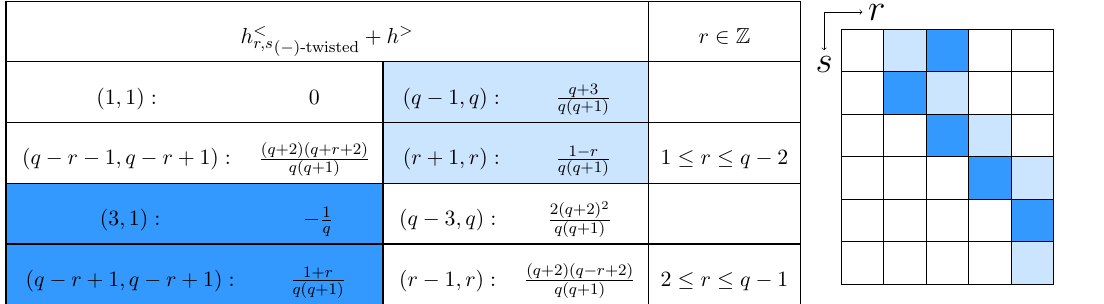
Table 4 . ( (cid:0) )-twist on special Neveu-Schwarz states. The numbers ( r; s ) in parenthesis determine the Coulomb gas representation used to calculate the weights after twist. One of the two possible representations (dark and pale blue cells) is dimensionless after ( (cid:0) )-twist in the limit q ! 1 . larger or equal to zero, just like N = 2 chiral primaries. Complementary